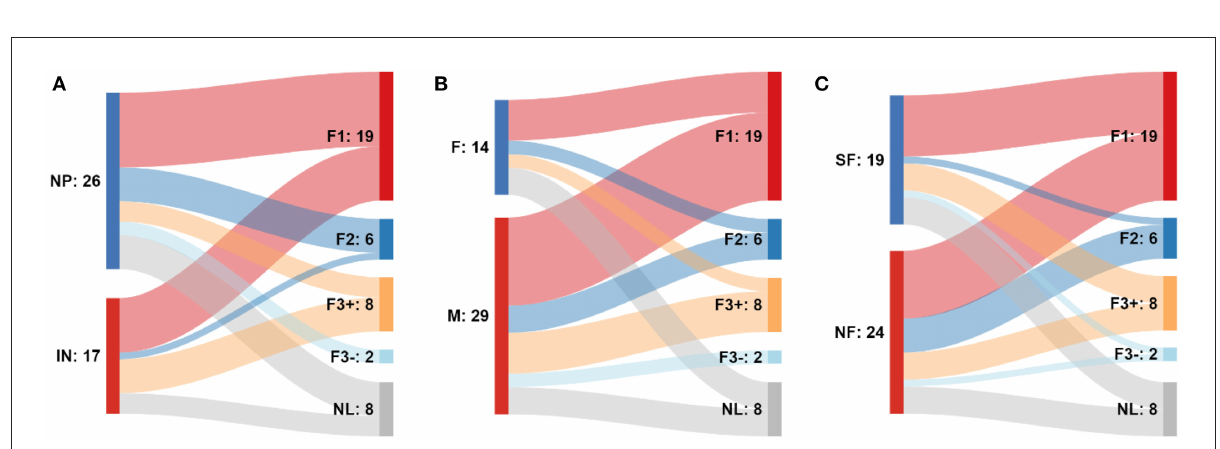
FIGURE5 Noncumulative distribution of respondents of SF-NF segment across factors (F1, F2, F3 Acronyms: Nepal (NP), Indonesia (IN), female (F), male (M), non-loaded respondents (NL).